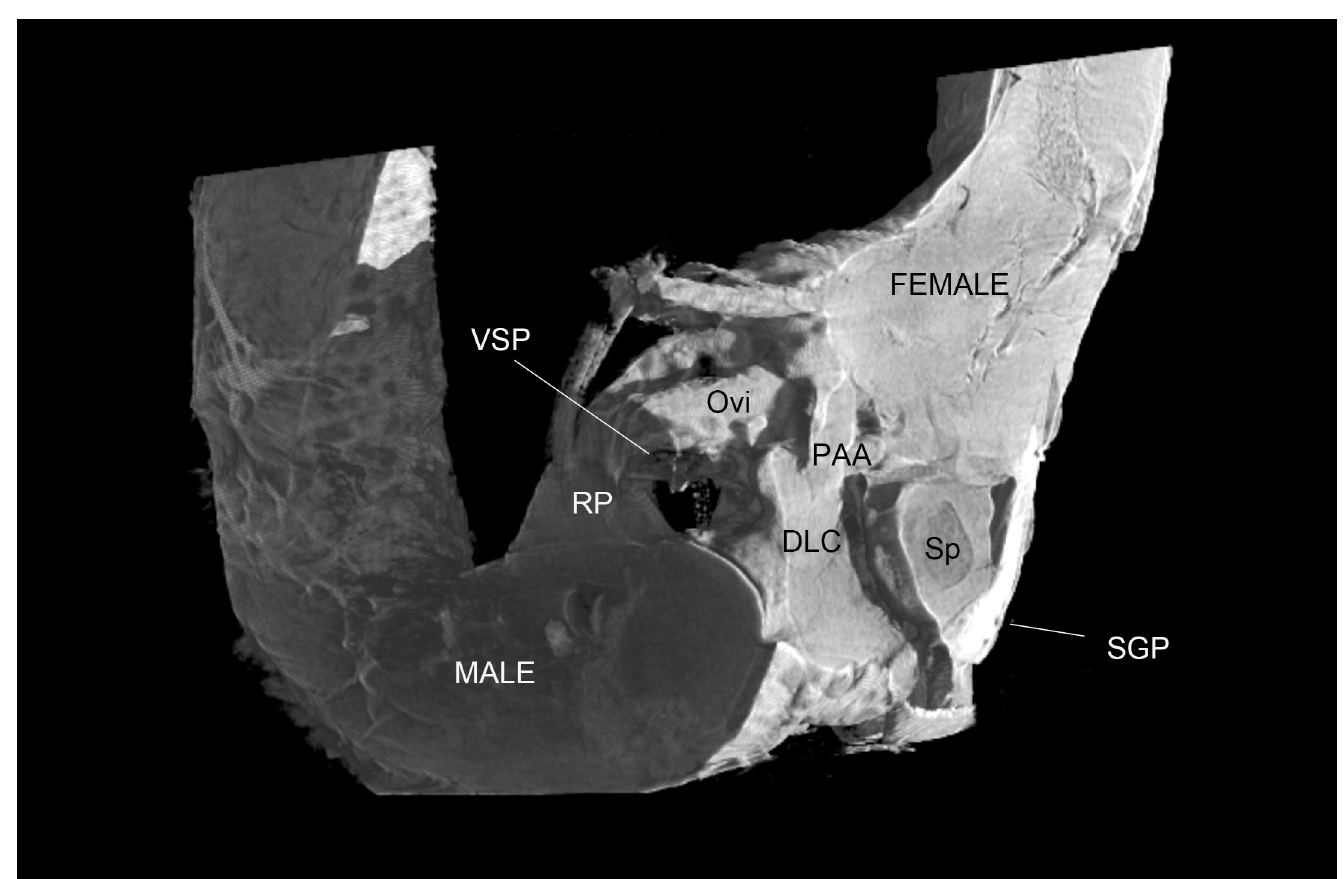
Fig 5. microCT 3D reconstructed image of interacting male and female genitalia sectioned along two planes. DLC = dorsal left complex; Ovi = ovipositor; PAA = processo apicale; RP = right phallomere; SGP = sub-genital plate; Sp = spermatophore; VSP = ventral sclerotised process